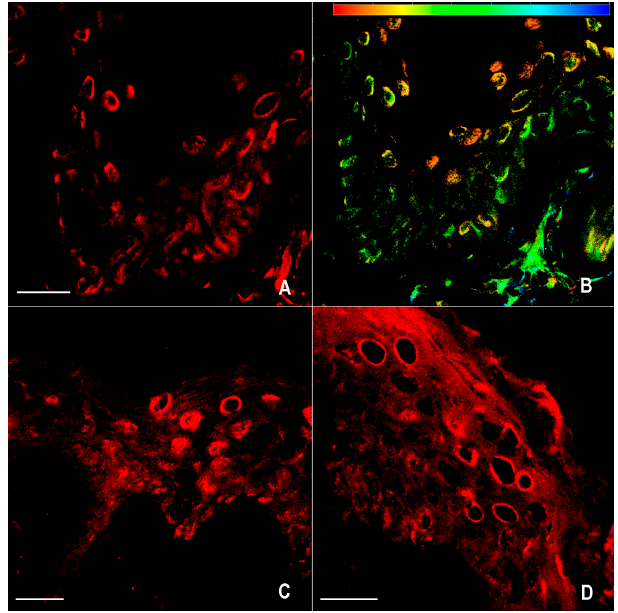
Figure 3. Inflammatory/lesional vitiligo skin: immunofluorescence staining of nNOS ( A – D ). Confocal image obtained in “overlay” mode showed nNOS expression in in the stratum basal of epidermis. nNOS was also detected in the cell body of melanocytes in the suprabasal layers. ( B ) Three-dimensional reconstruction obtained in depth coding mode. The colors reveal the spatial distribution (arrangement) of nNOS throughout the thickness of the section. ( A , B ) Argon laser (568 nm) lens 3, zoom 2, original magnification 40×. bar = 25 µm; ( C , D ) Argon laser (568 nm) lens 3, zoom 1,1, original magnification 40×. bar = 25 µm.